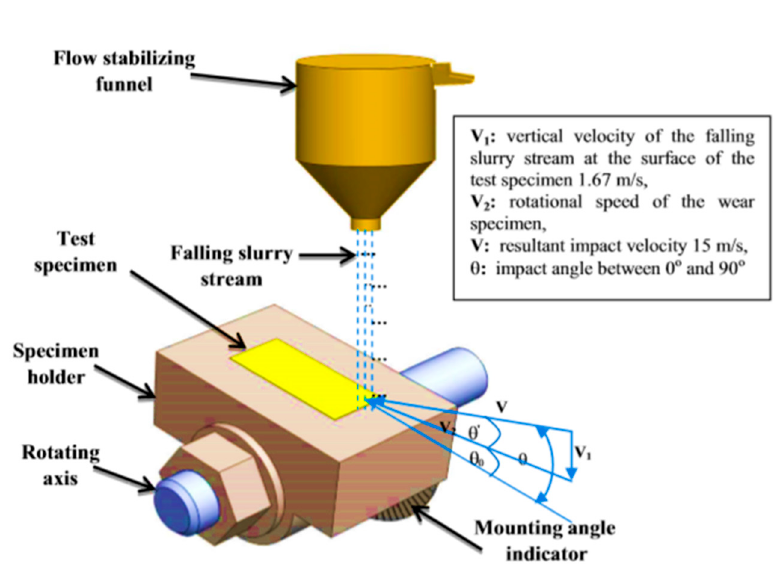
Figure 5. Schematic diagram of the impact angle and impact velocity.